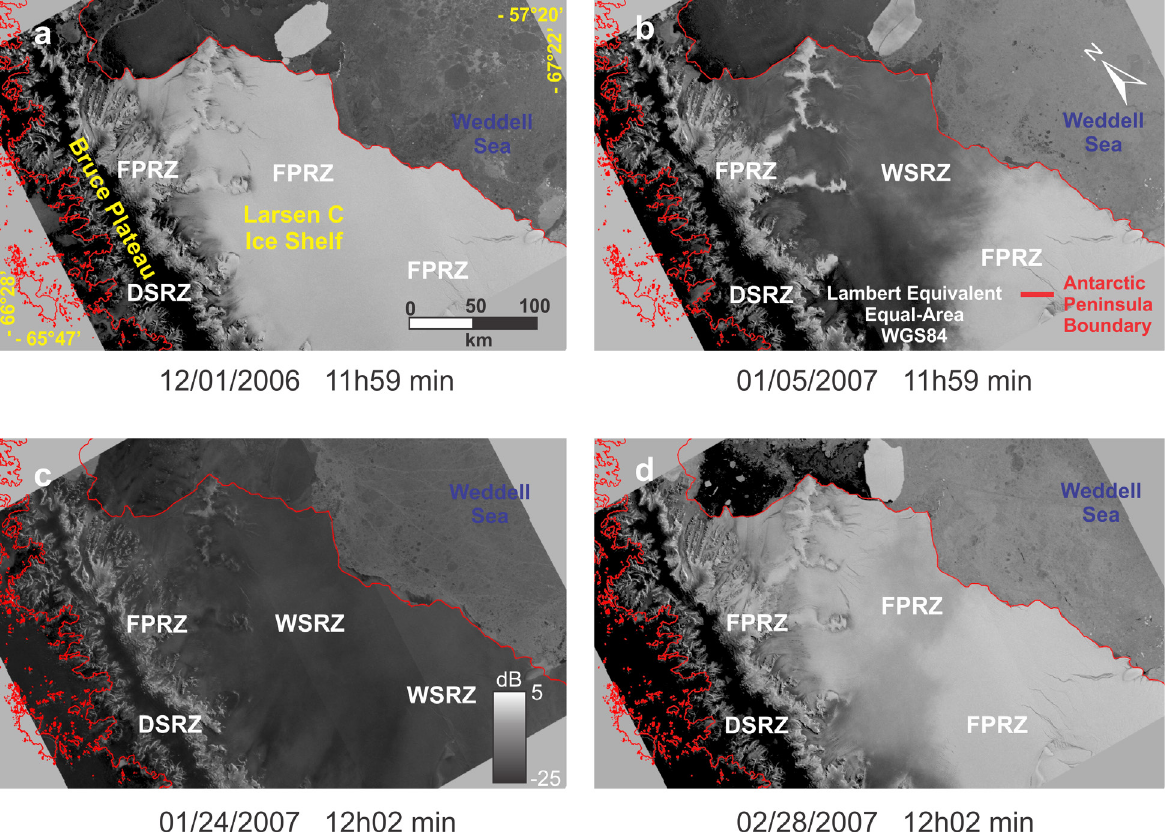
Figure 6. Subset of ASAR image on wide swath mode used in this study (dB scale), acquired in the austral summer of 2006-2007, covering the Larsen C ice shelf and the Bruce plateau. Dry Snow Radar Zone (DSRZ), Percolation Radar Zone (FPRZ) and Wet Snow Radar Zone (WSRZ) areas were classified in these images based on their backscatter values. The lighter gray tones represent higher backscatter values from the FPRZ areas, while the darker ones represent smaller backscatter values from the DSRZ and WSRZ